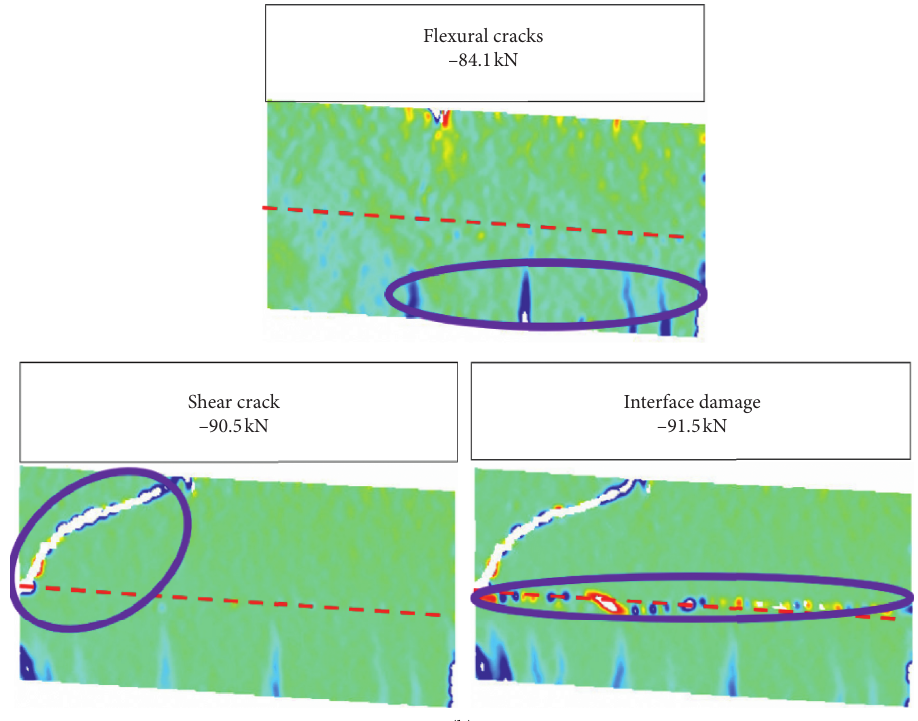
Figure 13: Failure patterns and damage evolutions of specimen U70. (a) Photos for failure pattern. (b) Damage tracking with DIC system.